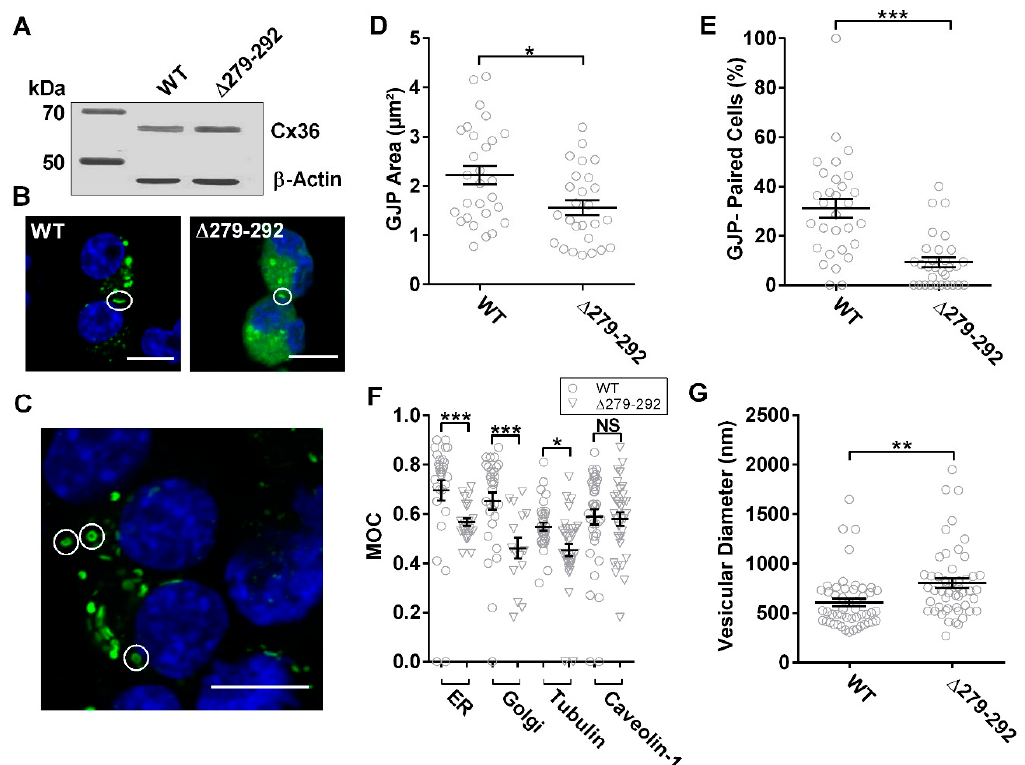
Figure 2. Loss of interaction between tubulin and Cx36 promotes intracellular localization. ( A ) Immunoblot analysis of Neuro-2a cells transiently transfected to express EGFP-tagged wild-type and ∆ 279–292 Cx36 constructs. Fusion proteins were detected using an anti-EGFP antibody